Question: What direction does the quantity move in — increasing or decreasing?
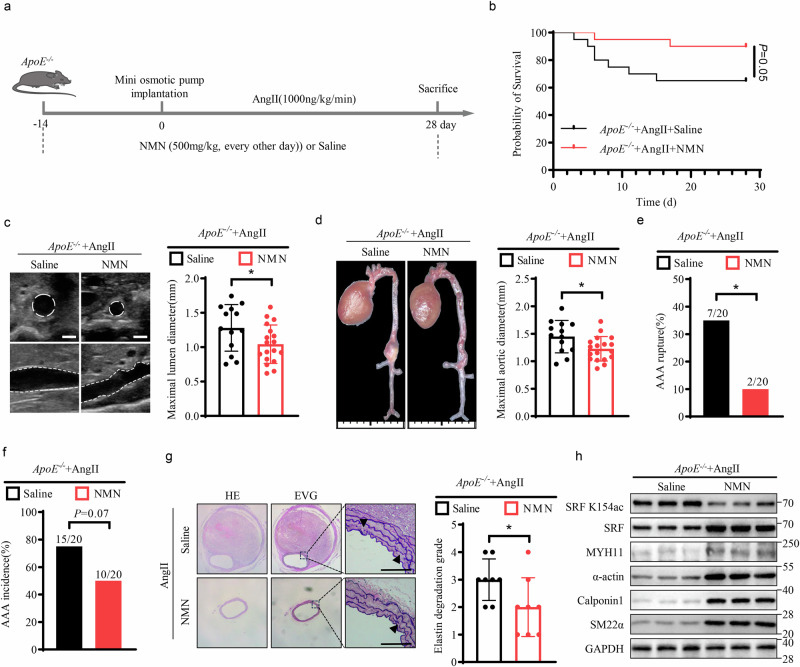
Answer: increasing